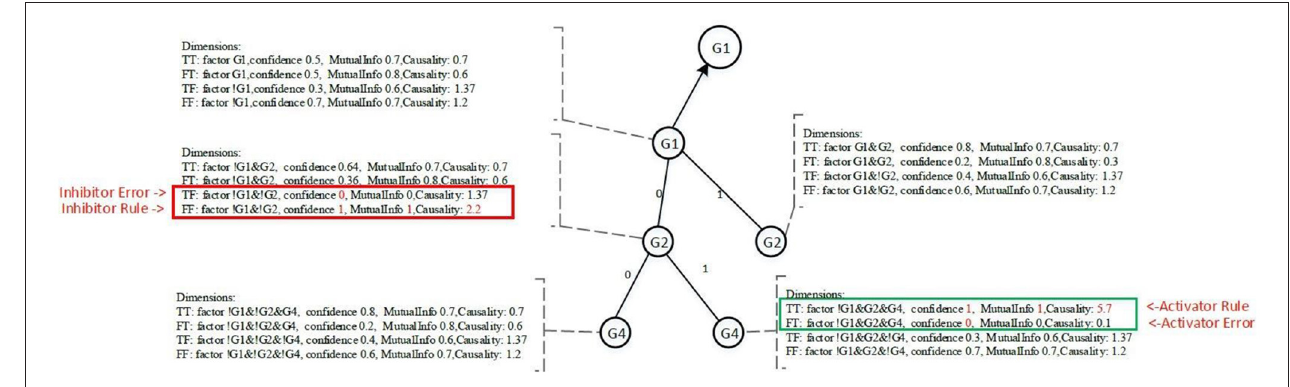
FIGURE 5 | Sample nodes and